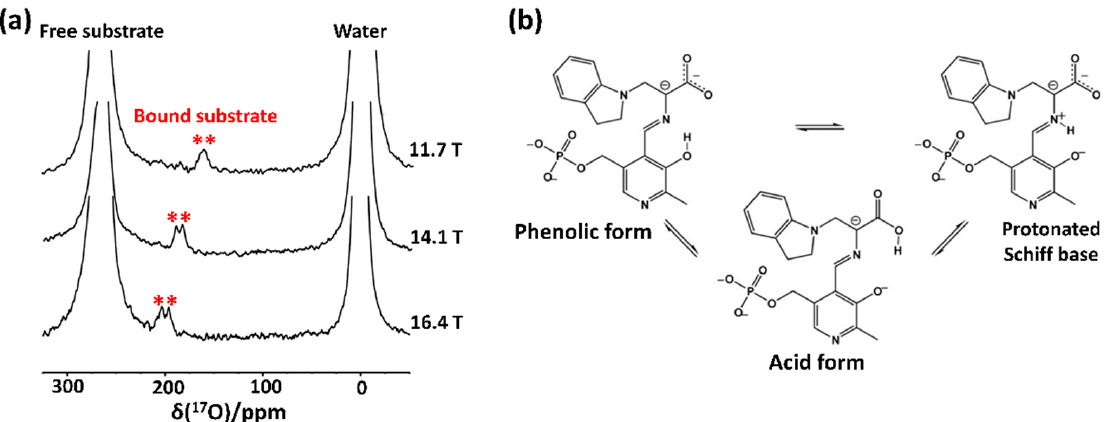
Figure 3. 17 O QCT NMR approach for the E(Q 3 ) indoline intermediates of tryptophan synthase. ( a ) The solution-state 17 O QCT NMR spectra of the E(Q 3 ) indoline intermediate in tryptophan synthase measured at different magnetic fields of 16.4 T, 14.1 T, and 11.7 T, respectively. The 17 O signals from the enzyme-bound intermediates are marked with red asterisks. ( b ) Illustration of exchange between tautomeric forms of the E(Q 3 ) indoline quinonoid intermediate. The figure was reproduced with permission from [54].